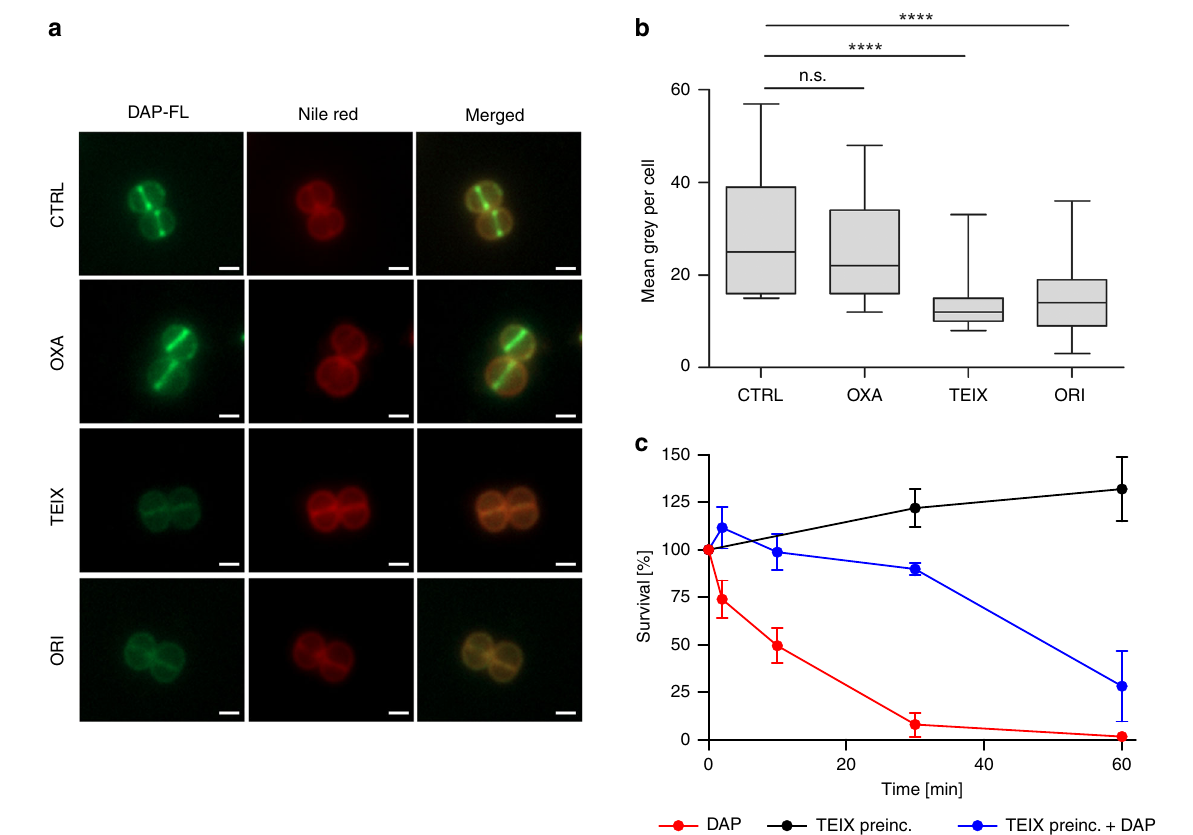
Fig. 3 Pre-incubation with lipid II-binding antibiotics prevents DAP binding to S. aureus and delays DAP-induced killing. a Binding of DAP-FL to S. aureus cells (OD = 0.5) pre-incubated with cell wall targeting antibiotics (oxacillin (OXA), teixobactin (TEIX) and oritavancin (ORI) (4-fold MIC)). After 600 pre-incubation for 2 min, cells were washed and incubated with DAP-FL in the presence of Ca 2 + for 10 min followed by washing and the addition of nile red membrane stain. Cells were washed again and subjected to fl uorescence microscopy. In a control (CTRL) pre-incubuation with antibiotics was omitted. Scale bar 1 µ m. Representative images are shown. b Quanti fi cation of DAP-FL binding measured in the experiment as described in a . Binding is expressed as mean grey value per cell. Box plots represent the interquartile range of the data. The black bar represents the mean and whiskers represent minimal and maximal values, respectively. At least n = 350 cells were evaluated for each condition from three biologically independent experiments. Signi fi cance was determined by unpaired Student ’ s t -test with a 95% con fi dence interval. **** p < 0.0001, n.s., not signi fi cant ( p = 0.0835). c Survival of S. aureus challenged with DAP (10 µ g ml − 1 ) without (red line) or with (blue line) pre-incubation with TEIX as described in a . Bactericidal effects were not observed in cells only pre-treated with TEIX (black line). Data presented are mean values from n = 3 biologically independent experiments. Error bars represent the standard deviation (SD). Source data are provided as a Source Data fi